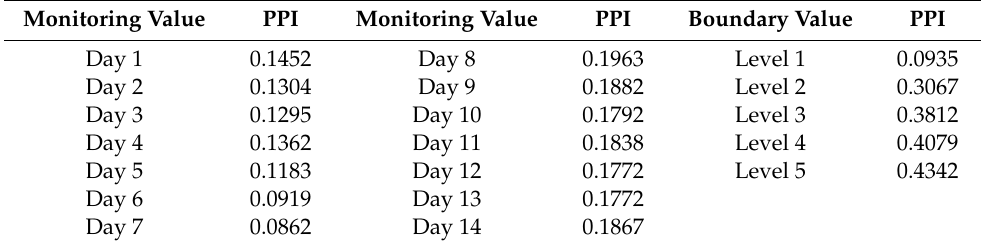
Table 12. The calculation results of the priority performance indices (PPIs).